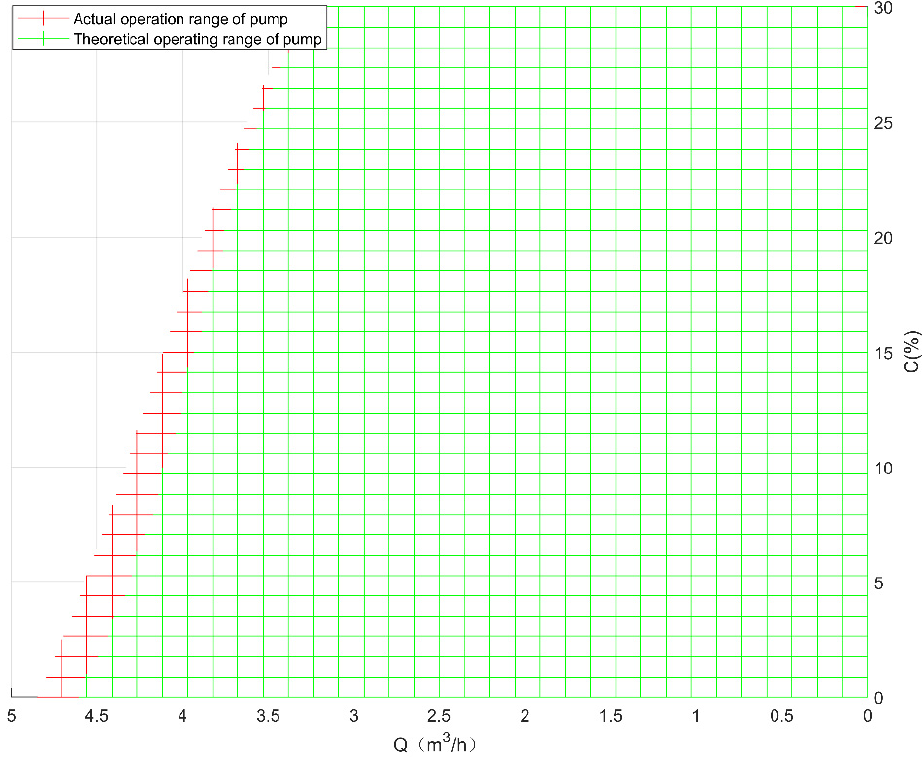
Figure 8. Operation range of pump.